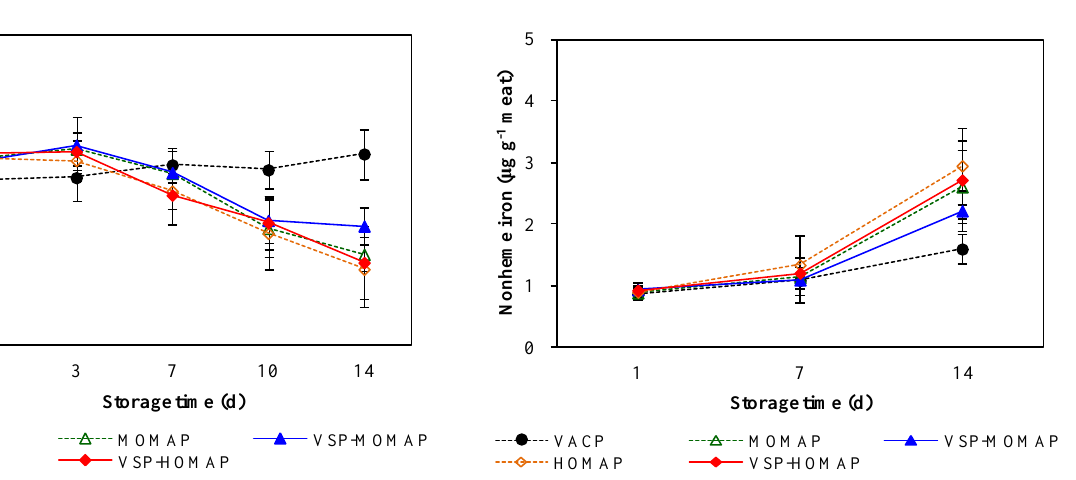
Figure 6. Nonheme iron content in sliced Hanwoo (Korean cattle) beef loin in packaging systems for 14 d at 4°C. Data are presented as means±SD. VACP, vacuum packaging; MOMAP, medium oxygen-modified atmosphere packaging (50% O 2 /20% CO 2 /30% N 2 ) alone; VSP-MOMAP, MOMAP combined with vacuum skin packaging; HOMAP, high oxygen-MAP (80% O 2 /20% CO 2 /0% N 2 ) alone; VSP-HOMAP, HOMAP combined with VSP; SD, standard